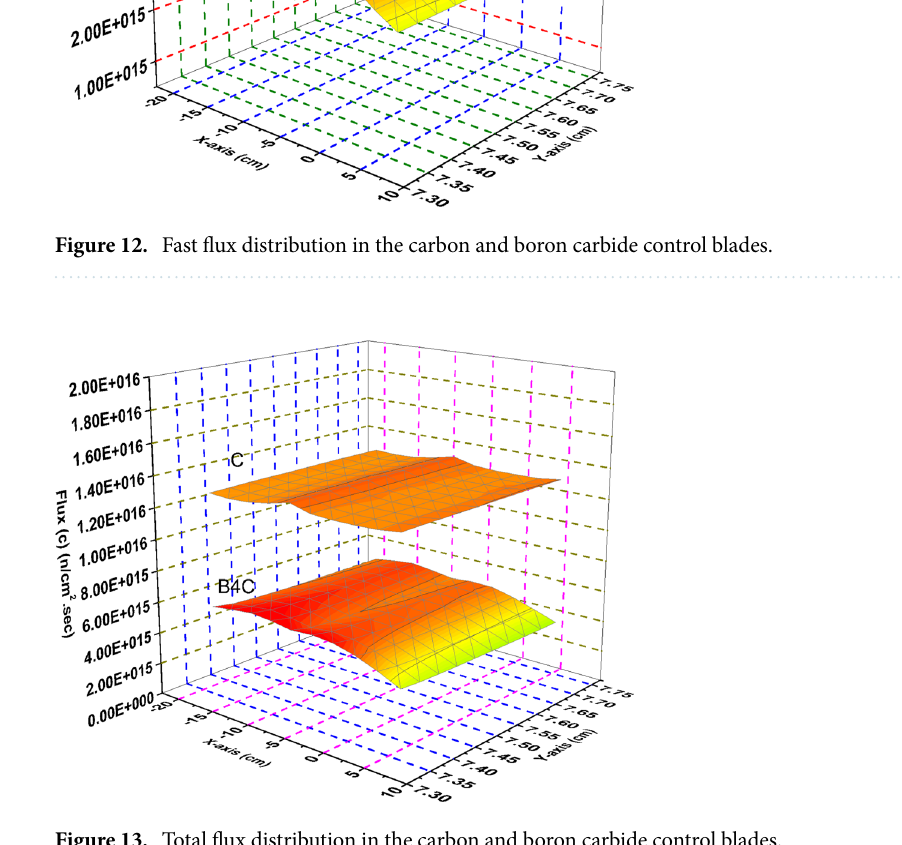
Figure 13. Total flux distribution in the carbon and boron carbide control